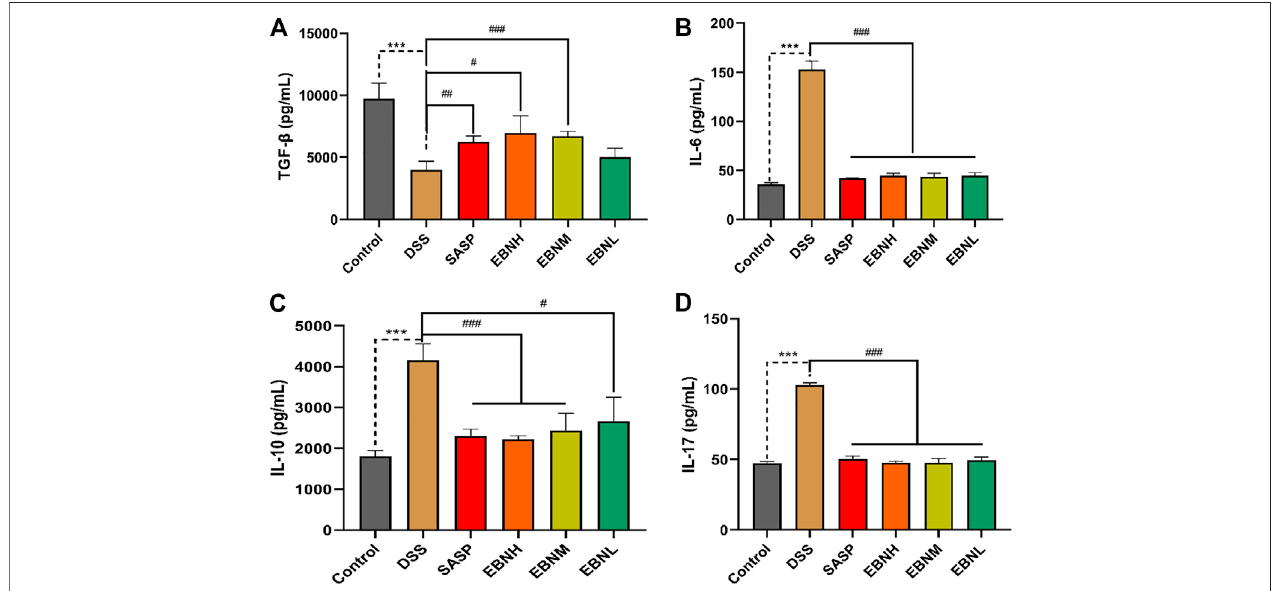
FIGURE4| EffectsofEBNpretreatmentontheexpressionofTh17andTregcell-associatedcytokinesincolonictissues. (A – D) EffectsofEBNontheexpressionof TGF- β , IL-6, IL-10 and IL-17 in colonic tissues. *** P < 0.001 compared with the control group; # P < 0.05, ## P < 0.01 and ### P < 0.001 compared to the DSS group ( x ± S , n (cid:2)